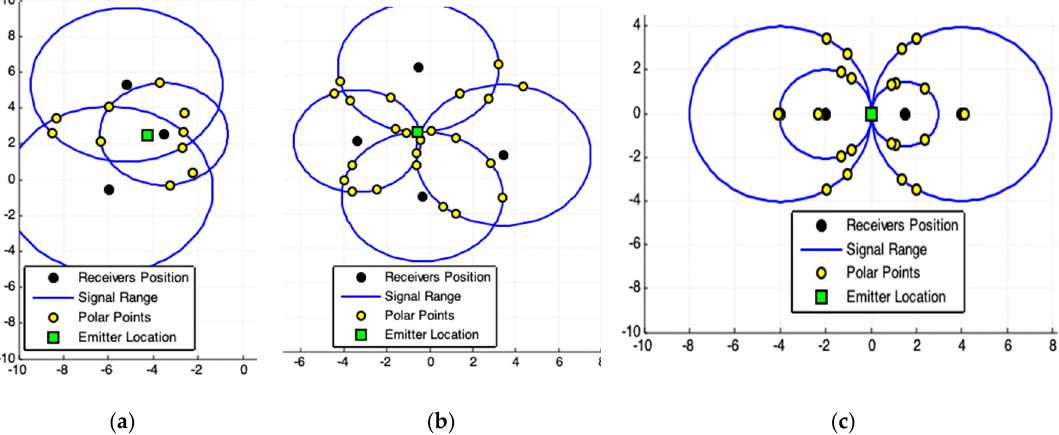
Figure 4. ( a ) Incoherence in data. The spatial position of a receiver is inside of range of another receiver. In this case, some polar-points are complex numbers (see the polar-points out of the line circles)—but their real parts belong to the region of interest (ROI). ( b ) Accurate data. Exact solution produced by PPC using redundant data (four receivers). For this case, is better applying the exact solution providing by Section 2.1. ( c ) Accurate data. A collinear arrangement among receivers (geometric arrangement not recommended) and the exact solution provided by PPC. The solution to this problem is impossible for Weighted Least Squares (WLSm), Least-Square (LSm), and Newton–Rapson (NRm). Algorithm 1. PPC—Polar-Points Centroid Model Data Input